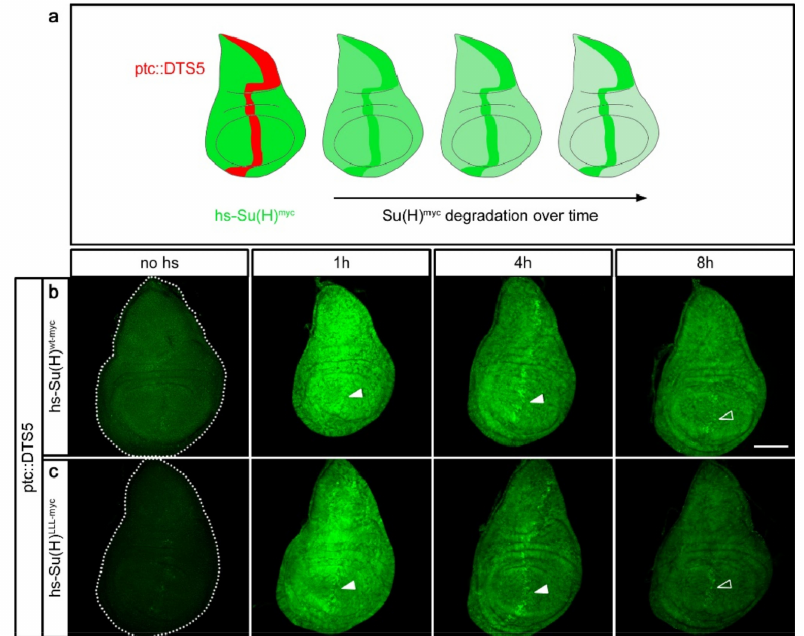
Figure 2. Su(H) is subjected to proteasomal degradation. ( a ) Scheme of the experimental design [51] showing cartoons of wing imaginal discs. Proteasomal activity is inhibited specifically along the antero–posterior boundary by overexpressing the DTS5 mutant in the ptc-pattern at restrictive temperature, indicated by a red stripe (ptc::DTS5). The protein of interest, shown in green, is induced ubiquitously by a short heat pulse. It is degraded over time except in the domain of proteasomal malfunction (green stripe). ( b ) hs-Su(H) wt-myc and ( c ) hs-Su(H) LLL-myc protein expression in the ptc::DTS5 background, monitored over time as indicated. Note the enrichment of Su(H) protein along the antero–posterior boundary, indicating stabilisation in the absence of proteasomal activity (arrowheads). Size bar, 100 µ m in all panels. Genotypes are: ptc-Gal4/UAS-DTS5; hs-Su(H) wt-myc /+ ( b ) and ptc-Gal4/UAS-DTS5; hs-Su(H) LLL-myc /+ ( c